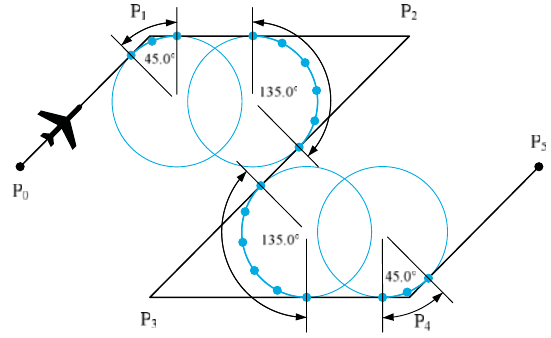
Fig. 2. Smoothing of a 6-waypoint trajectory using circular